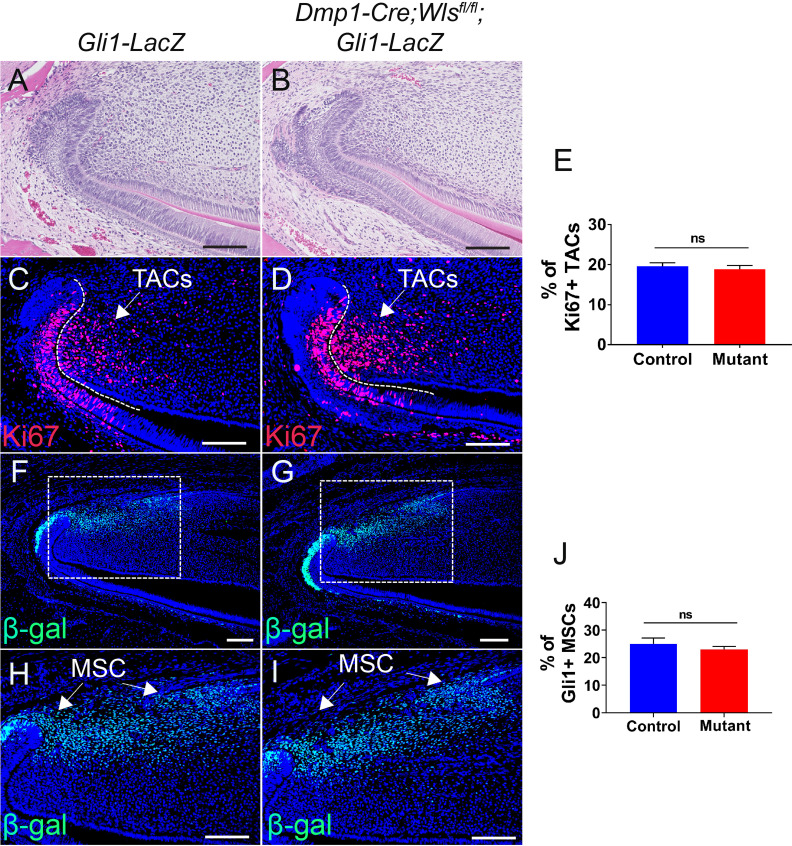
Loss of WNT signaling in odontoblasts has no effect on mesenchymal stem cells (MSCs) or transit amplifying cells (TACs).(A–D) H and E staining and Ki67 immunofluorescence (red) of incisors from 2-month-old Gli1-LacZ (control) and Dmp1-Cre;Wlsfl/fl;Gli1-LacZ mice (mutant). (E) Quantitation of the percentage of Ki67+ cells per higher magnification section (C and D) of Gli1-LacZ and Dmp1-Cre;Wlsfl/fl;Gli1-LacZ incisor mesenchyme. (F–I) β-gal staining (green) of incisors from 2-month-old Gli1-LacZ and Dmp1-Cre;Wlsfl/fl;Gli1-LacZ mice. (J) Quantitation of the percentage of Gli1+ cells per higher magnification section (H and I) of Gli1-LacZ and Dmp1-Cre; Wlsfl/fl;Gli1-LacZ incisor mesenchyme. Arrows indicate positive signal. The white dashed lines outline the cervical loop. All quantitative data are presented as mean ± SD. ns, no significance. Four mice with four sections within each mouse per group were used to quantify Ki67+ cells. Gli1+ cells in the proximal region between the two cervical loops were counted in the mouse incisor. Scale bars, 100 μm.Figure 4—figure supplement 2—source data 1.Source data for Figure 4—figure supplement 2E and J.